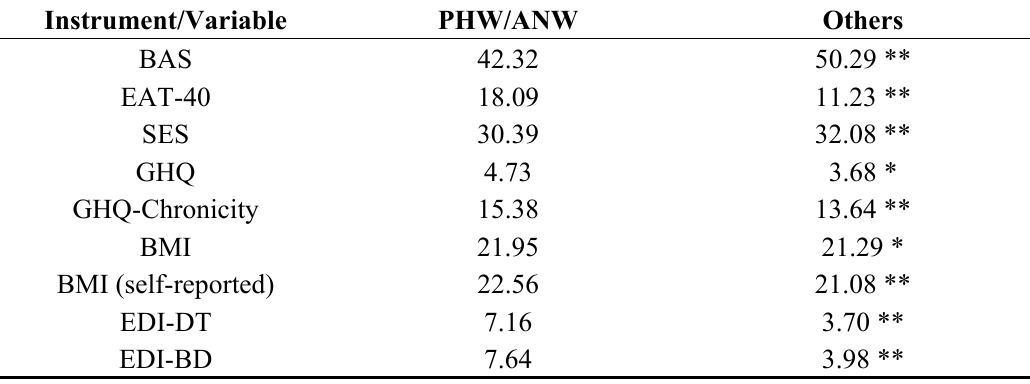
Table 3. Differences between participants who perceived their weight as high (PHW) but who had an actual normal weight (ANW) and the rest of